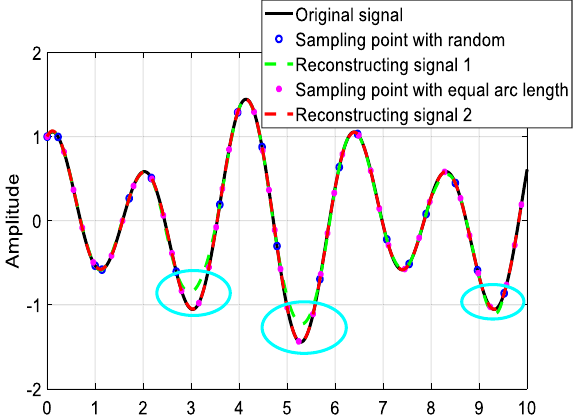
Fig. 6 Composite signal, sampling points with random and equal arc length, and reconstructing signals,